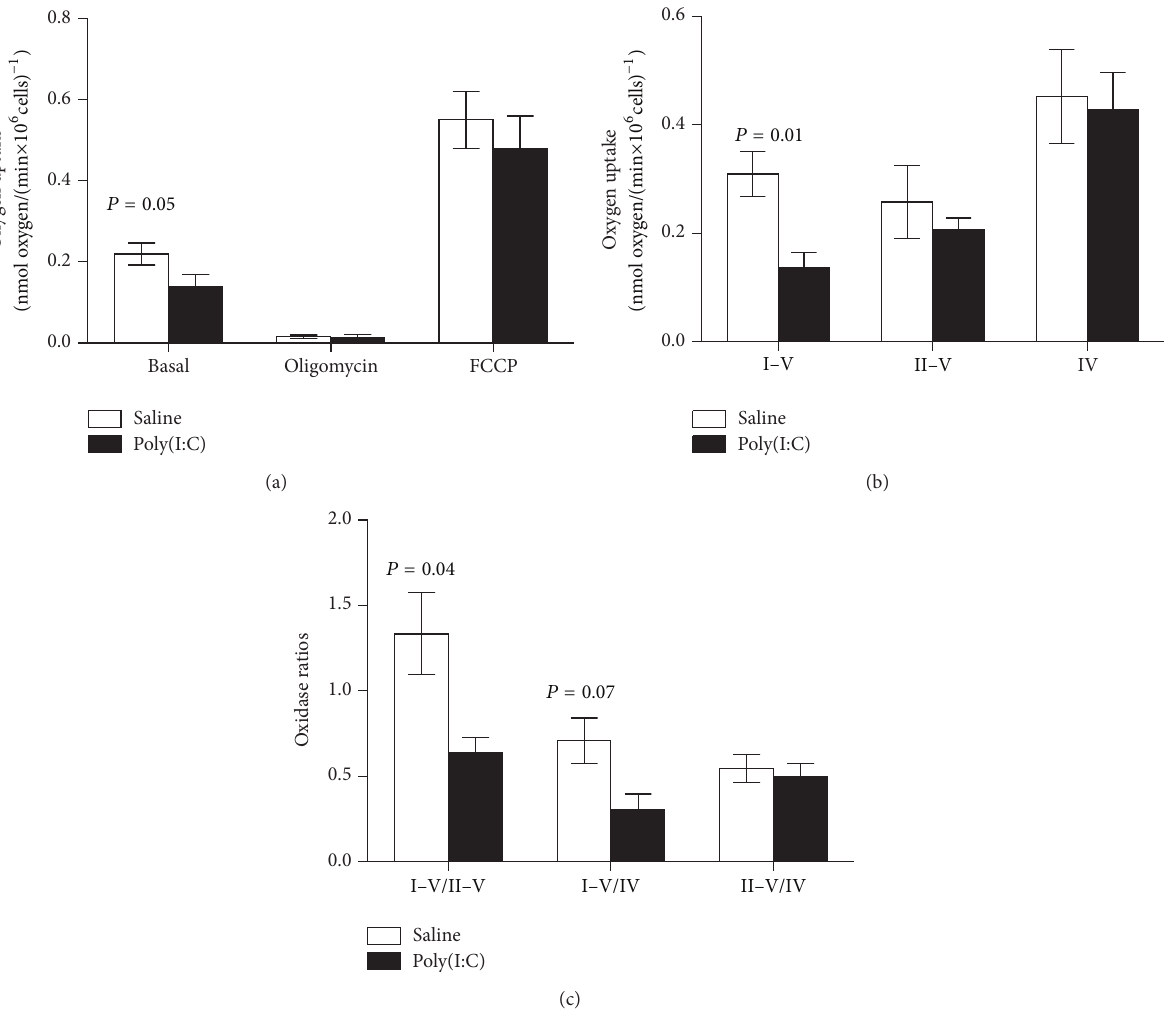
Figure 1: Mitochondrial outcomes in splenocytes. Splenocytes from offspring (10–12 weeks old) poly(I:C)- (𝑛 = 8) or saline- (𝑛 = 8) treated dams at 12.5 gestational day were isolated, and mitochondrial outcomes were tested as described in detail in Section 2. (a) Oxygen uptake of intact cells was determined using a Clark-type electrode in Hanks balanced salt solution (HBSS) supplemented with 6mM glucose as substrate. Basal (only glucose), oligomycin (0.2 𝜇 M), and FCCP (20 𝜇 M) were added, and the initial rates of oxygen uptake were calculated and normalized by million cells. (b) Permeabilized cells were tested for their capability to consume oxygen coupled to ATP production by supplementing the media with malate-glutamate (or NADH oxidase comprised by complexes I–V), succinate with rotenone (or succinate oxidase comprised by complex II–V), and TMP-ascorbate for cytochrome c oxidase activity (or complex IV). (c) ratio of rates of oxygen consumption in the presence of various substrates derived from